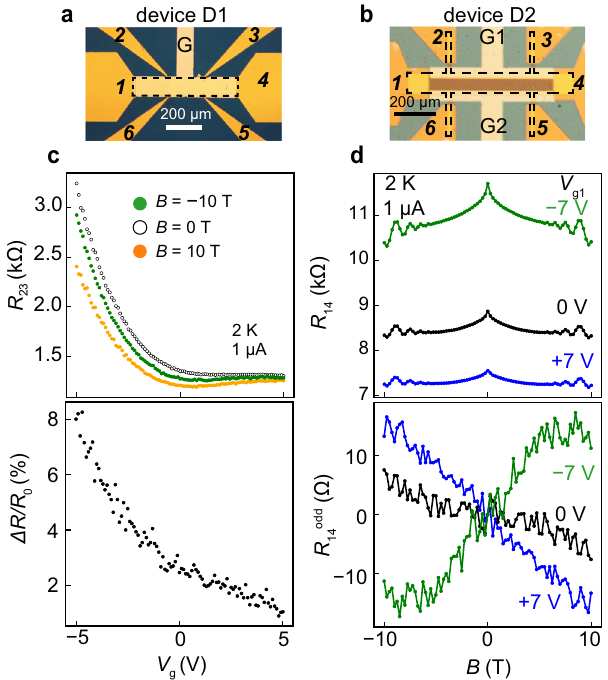
Fig. 3 | Electrical gating of the OMR. a , b Optical microscopy images of the Hall- bar fi eld-effect transistor (FET) device D1 with a top-gate G and D2 with separated gates G 1 and G 2 , respectively. These two devices are made from sample B. The dashedlineindicatestheoutlineoftheHallbars.Thelightanddarkyellowpartsare the Au pads of the gate and Hall-bar electrodes, respectively. c Gate voltage V g dependence of R 23 at various B of − 10T (green), 0T (white), 10T (orange) (upper panel),andthatoftheoddcomponent Δ R / R 0 (lowerpanel),where Δ R =( R 23 ( − 10T) – R 23 (+10T))/2, and R 0 = R 23 (0T), measured at 2K on device D1. These measure- ments are conducted with a fi xedcurrent of1 μ A at2K. d Magnetoresistance(MR) resultsof(toppanel)and theoddcomponents(bottompanel),measured at2Kon device D1. R 14 is the resistance measured between terminals 1 and 4 (two-terminal measurement). The MR results at V g1 = − 7, 0, +7V are shown in green, black, and blue lines,